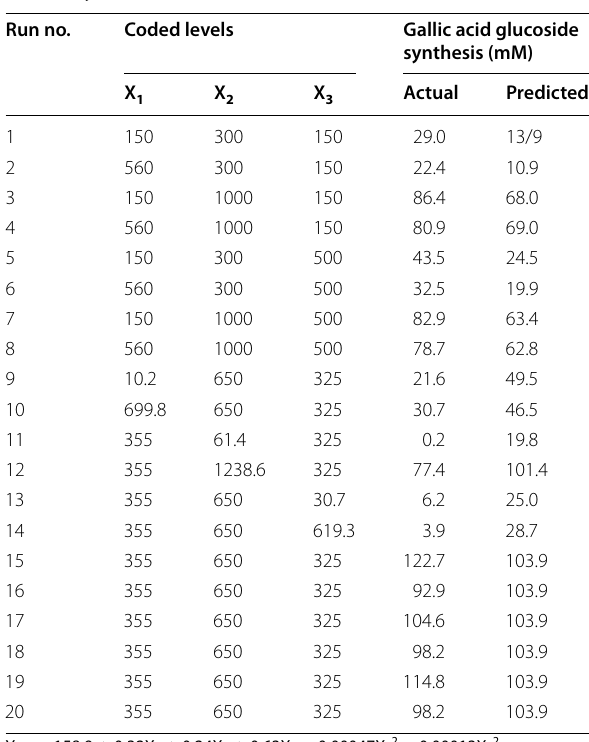
Table 1 Central composite design matrix for the experi- mental design and predicted responses for gallic acid glu- coside synthesis